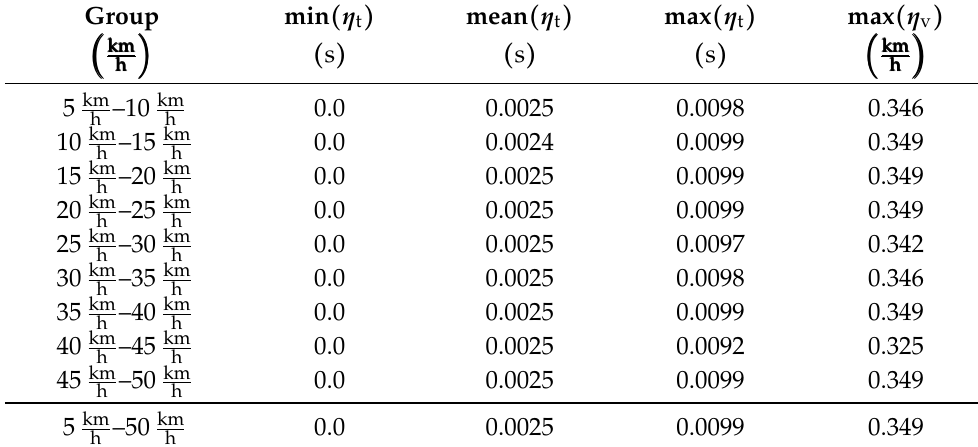
Table 7. Synchronization errors between an OBD and a reference sensor measurement. # of measure- ments: 3,428,099.